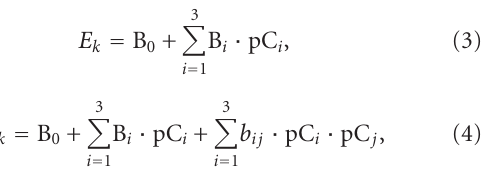
the phase of a solution and in the phase of the PSP was con- tained in the calibration coe ffi